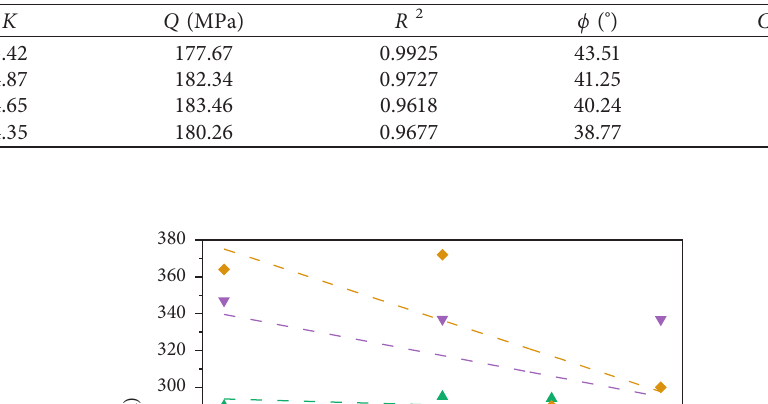
Table 2: The linear fitting results of confining pressures (5 ∼